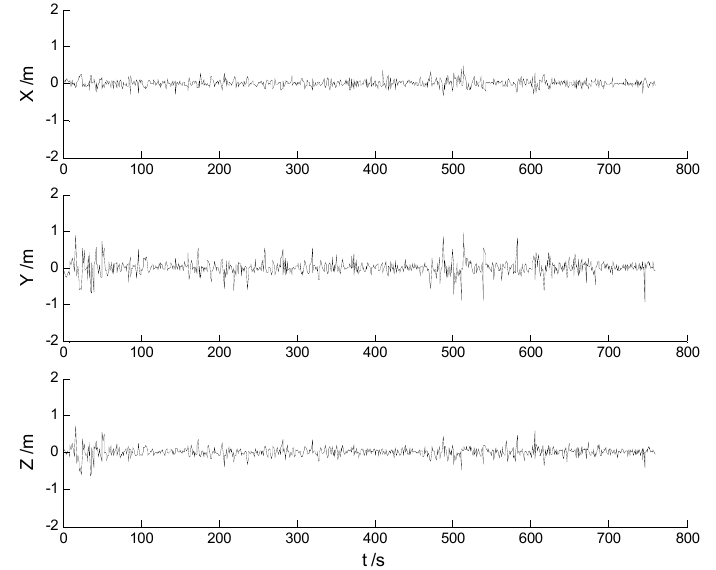
Figure 6. Position errors of the MHF-CKF algorithm.